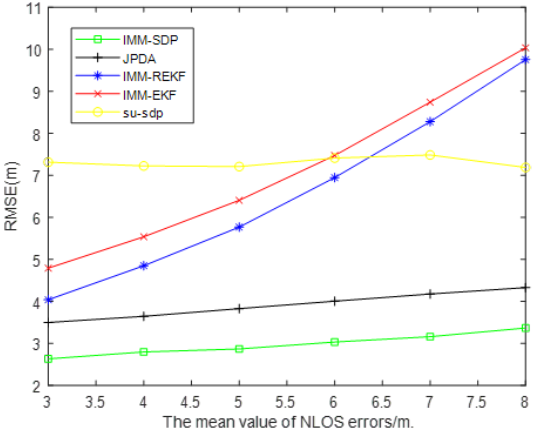
Figure 4. RMSE versus the mean value of NLOS errors .